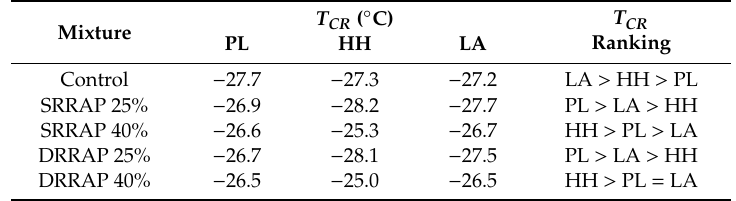
Table 6. Results of T CR ( ◦ C) based on the SAP approach (2 ◦ C / hour). Mixture